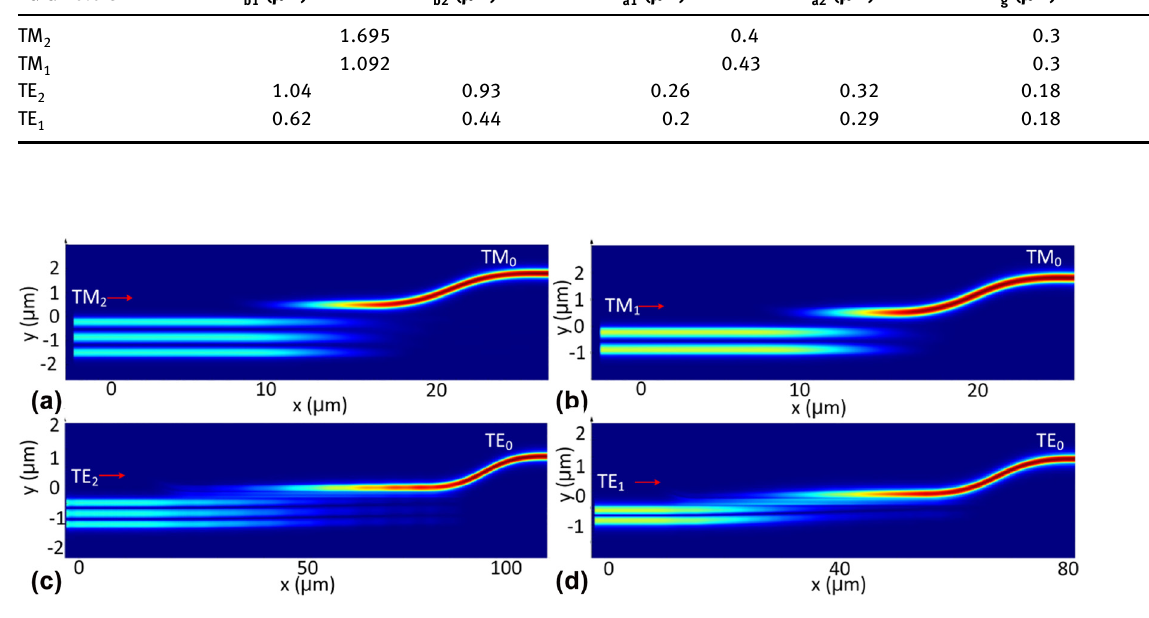
Figure 4: Light propagation of TM